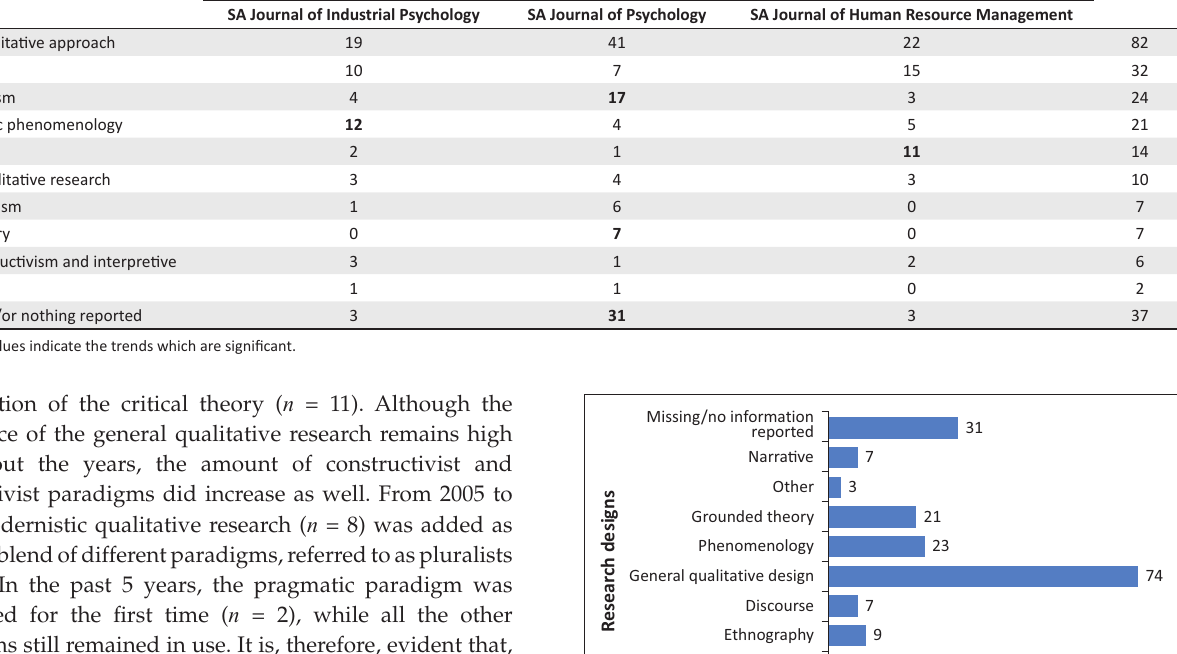
TABLE 2: Comparison of paradigm descriptions for the respective journals. Paradigms descriptions